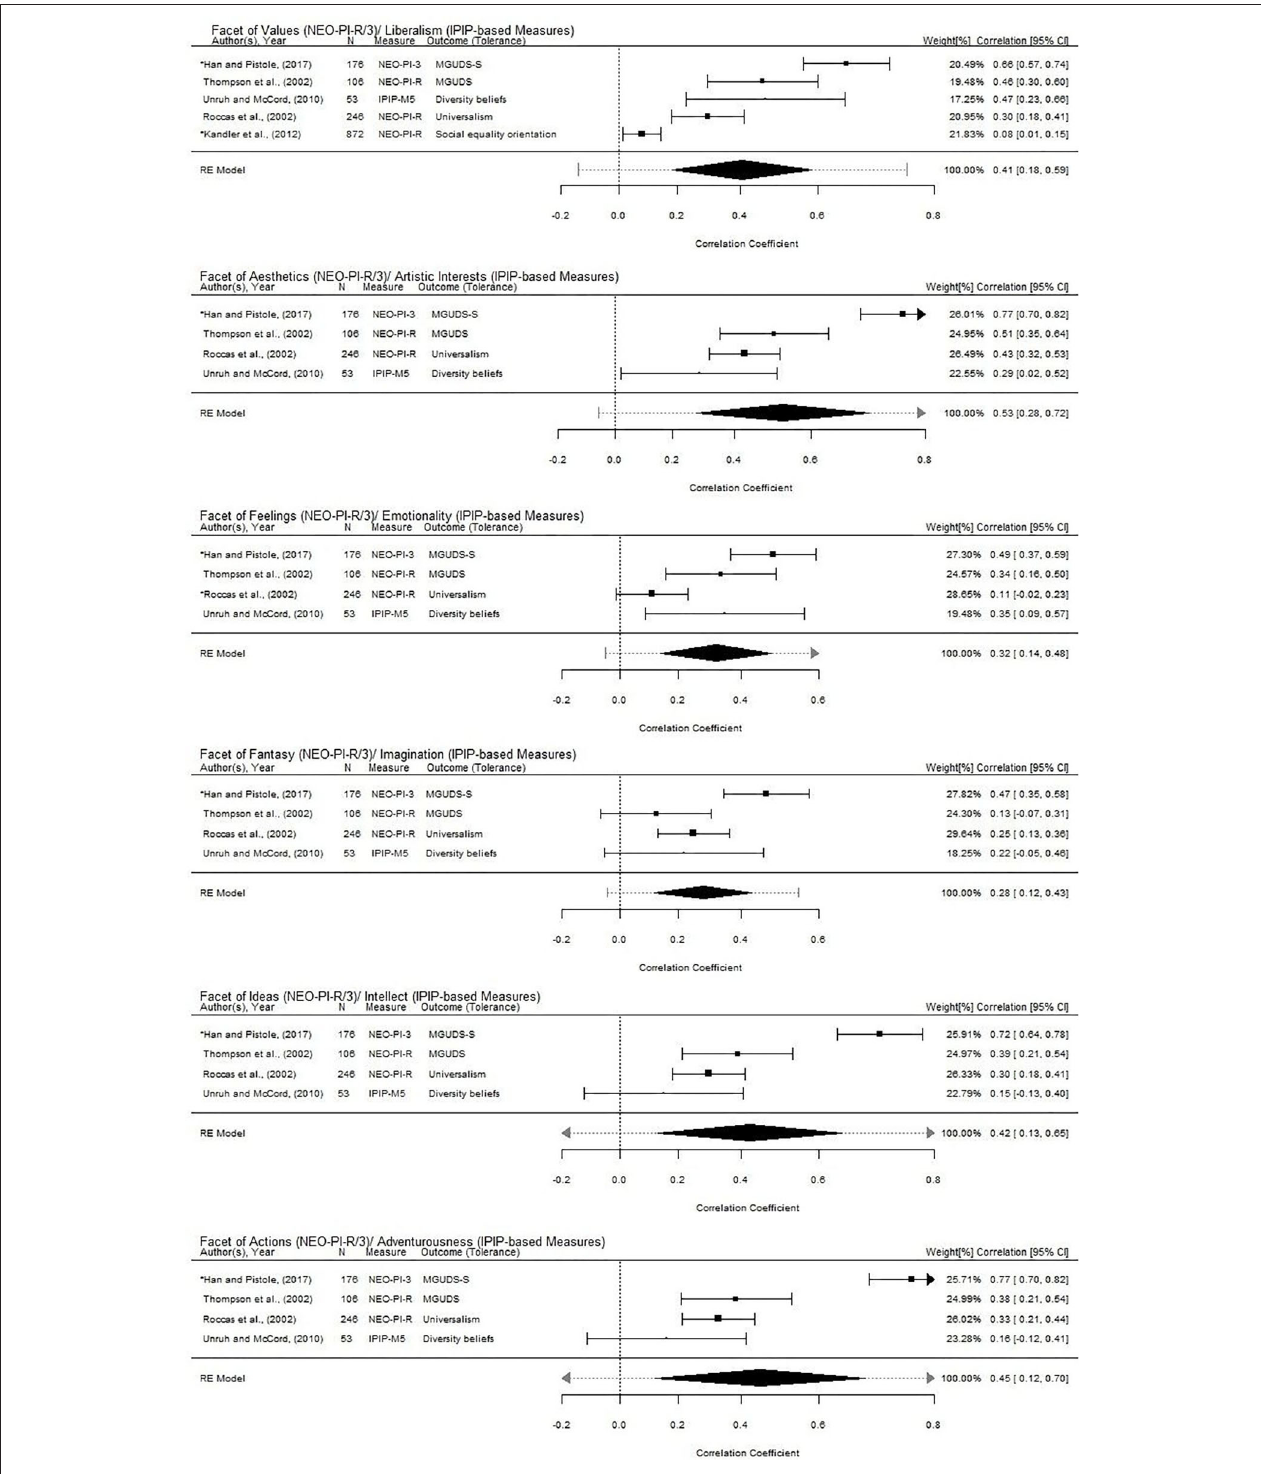
FIGURE 4 | Forest plots for the associations of the facets of openness with tolerance. The summary effect sizes are displayed as a polygon at the bottom of each plot with the width reflecting the 95% confidence interval of the average effect size estimate. The dotted line extending from the polygon reflects the 95% prediction interval which accounts for both the uncertainty of the effect size estimate and the uncertainty in the between-study variance estimate (Riley et al., 2011). Studies with larger squares contributed more to the summary effect sizes compared to the other studies. Studies with an asterisk (*) were potential outliers and influential cases as per studentized deleted residuals, Cook’s distances, and hat values for each